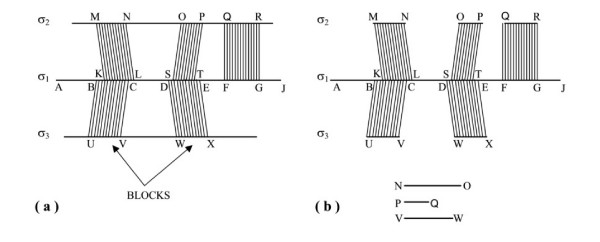
Orthologous promoters and blocks of sequence conservation. Shaded areas represent ungapped aligned blocks. σ1 is the reference species. (a) Alignment of input sequences and extraction of blocks. (b) Reorganization of input sequences.